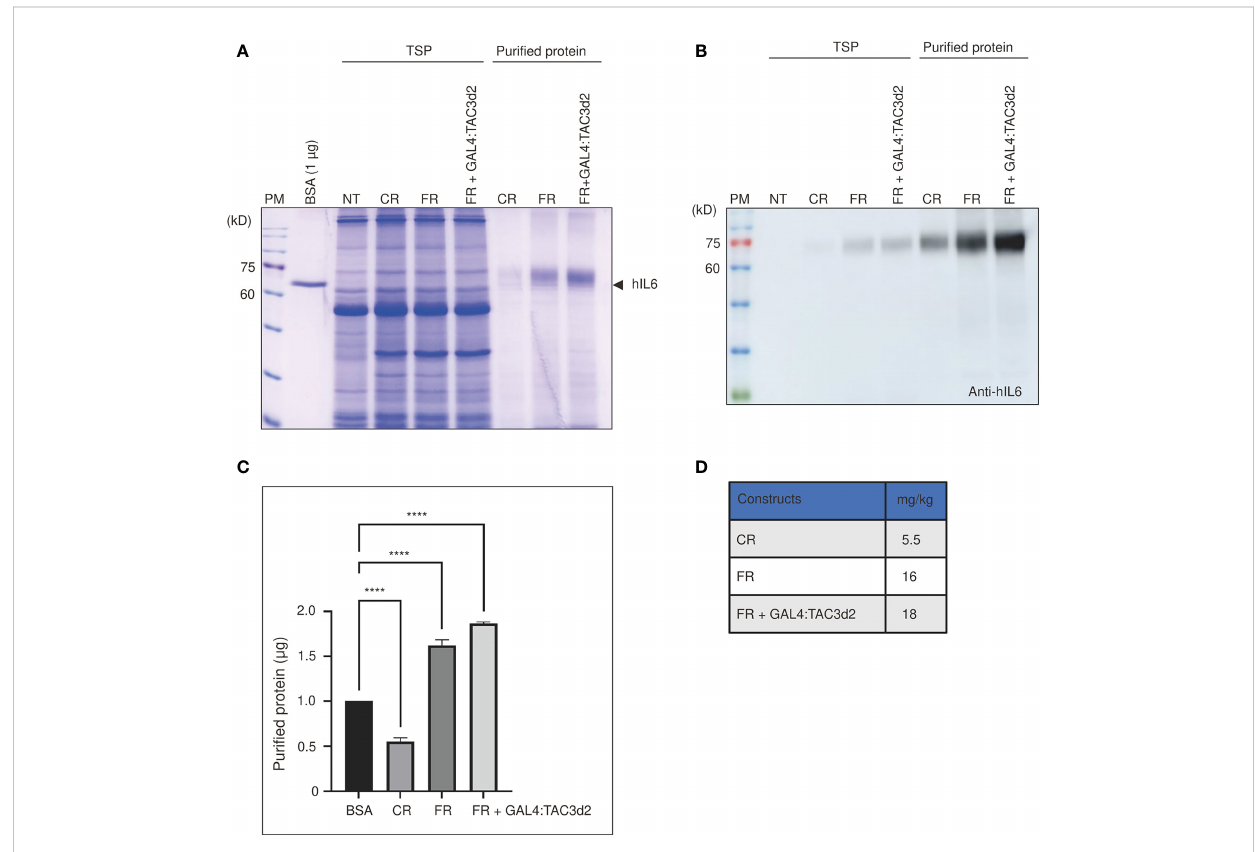
FIGURE 6 Puri fi ed proteins con fi rm the strong transcriptional activity from the hybrid FM ’ M-UD promoter with arti fi cial GAL4/TAC3d2 transcription factor. (A, B) Analysis of the expression levels of puri fi ed proteins. Total soluble proteins (TSP) were extracted from 100 mg fresh leaf tissue harvested at 5 dpi and puri fi ed using MCC beads. BMCS:hIL6 bound to MCC beads was released by boiling and analyzed using SDS/PAGE followed by CBB staining (A) or western blot analysis using anti-hIL6 antibody (B) . BSA (1 µg) was used as a reference protein for quanti fi cation. NT: wild-type plant